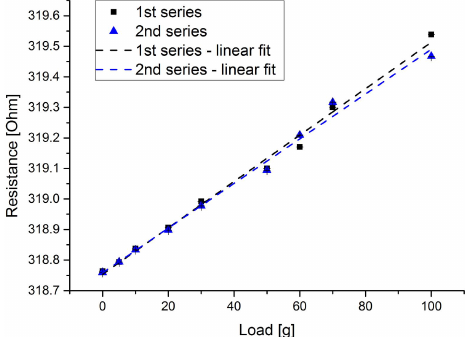
Figure 8. Diagram of the measured resistance of one single RSG and the applied load in